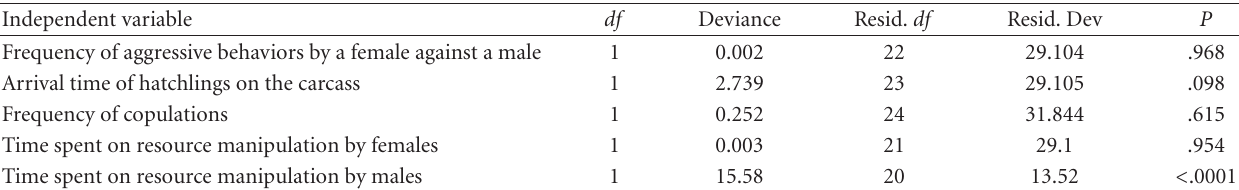
Table 1: Analysis of deviance from generalized linear model for the males to participate in the feeding of larvae. Independent